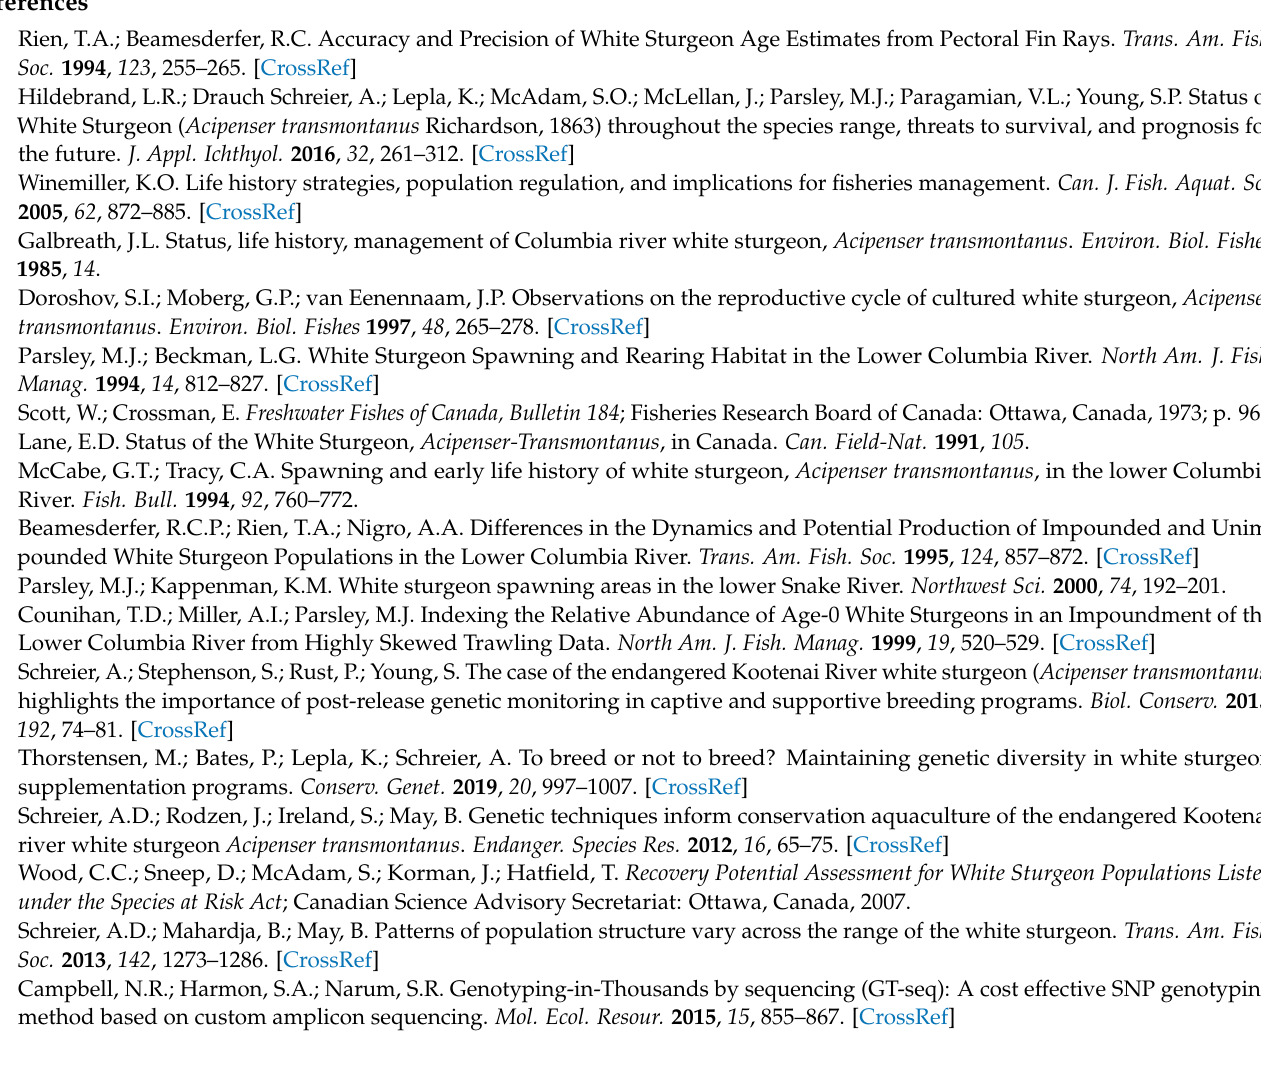
Table S1. Genetic markers omitted from analysis due to missing